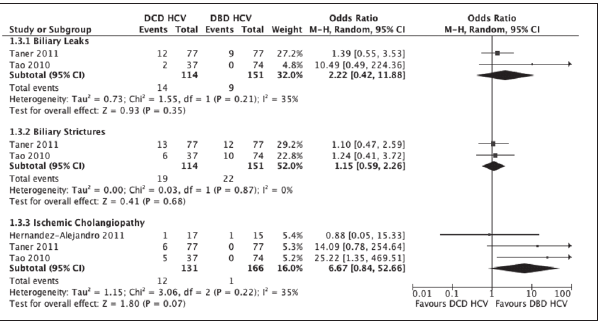
Figure 4) Forest plot of biliary complications. DBD Donation after brain death; DCD Donation after cardiac death; HCV Hepatitis C virus